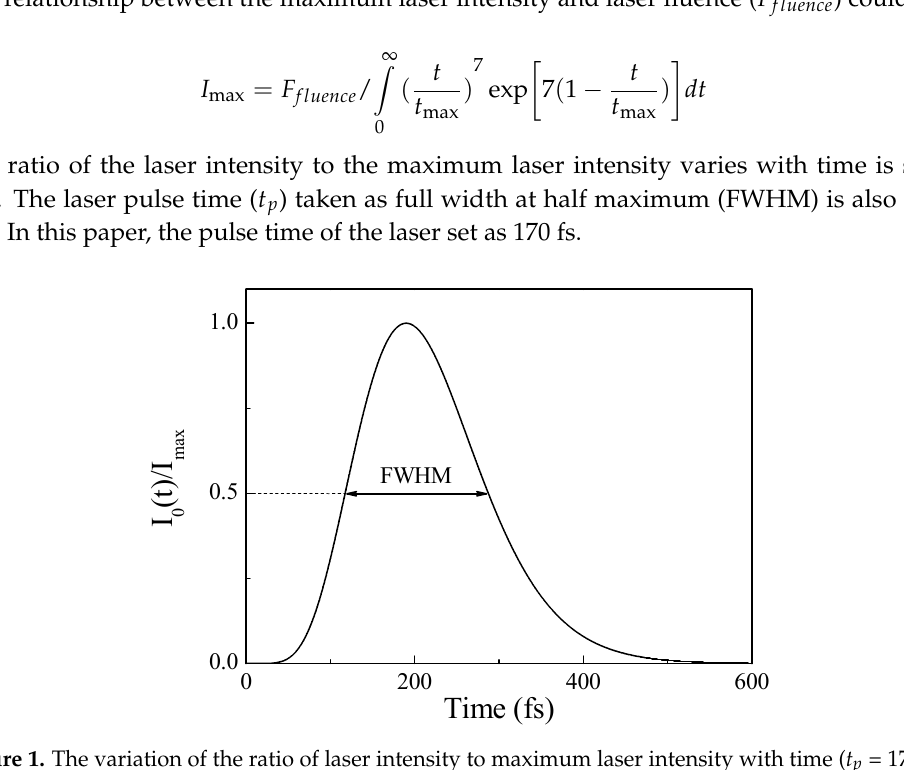
Figure 1. The variation of the ratio of laser intensity to maximum laser intensity with time ( t p = 170 fs).